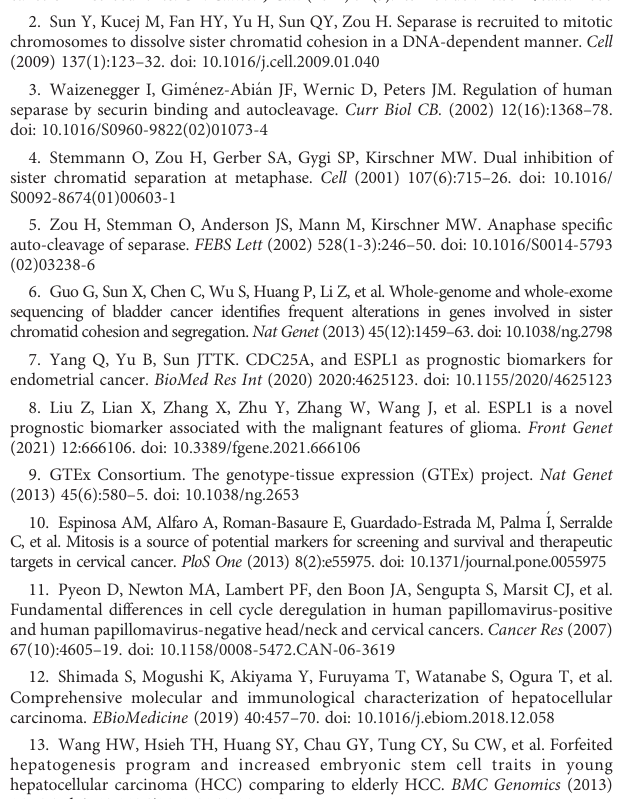
SUPPLEMENTARY FIGURE 1 Relationship between ESPL1 expression and pathological staging. ns. not signi fi cant; *, p<0.05; **, p<0.01; ***, p<0.001. SUPPLEMENTARY FIGURE 2 Validating the aberrant expression of ESPL1 through GEO. (A, B) Cervical cancer. (C, D) Liver cancer, (E, F) Lung cancer, (G, H) Colorectal cancer. SUPPLEMENTARY FIGURE 3 Relationship between ESPL1 expression and clinical information. (A) Box plots showing the relationship between ESPL1 expression and age. (B) Box plots showing the relationship between ESPL1 expression and gender. SUPPLEMENTARY FIGURE 4 Multivariate survival analysis based on ESPL1 expression and multiple clinical information. SUPPLEMENTARY FIGURE 5 The IC50 values of HCT116 and SW620 cells after siRNA-mediated interference of ESPL1 expression. (A and C) IC50 curves of three drugs in HCT116 and SW620 cells. (B and D) Column chart comparing IC50